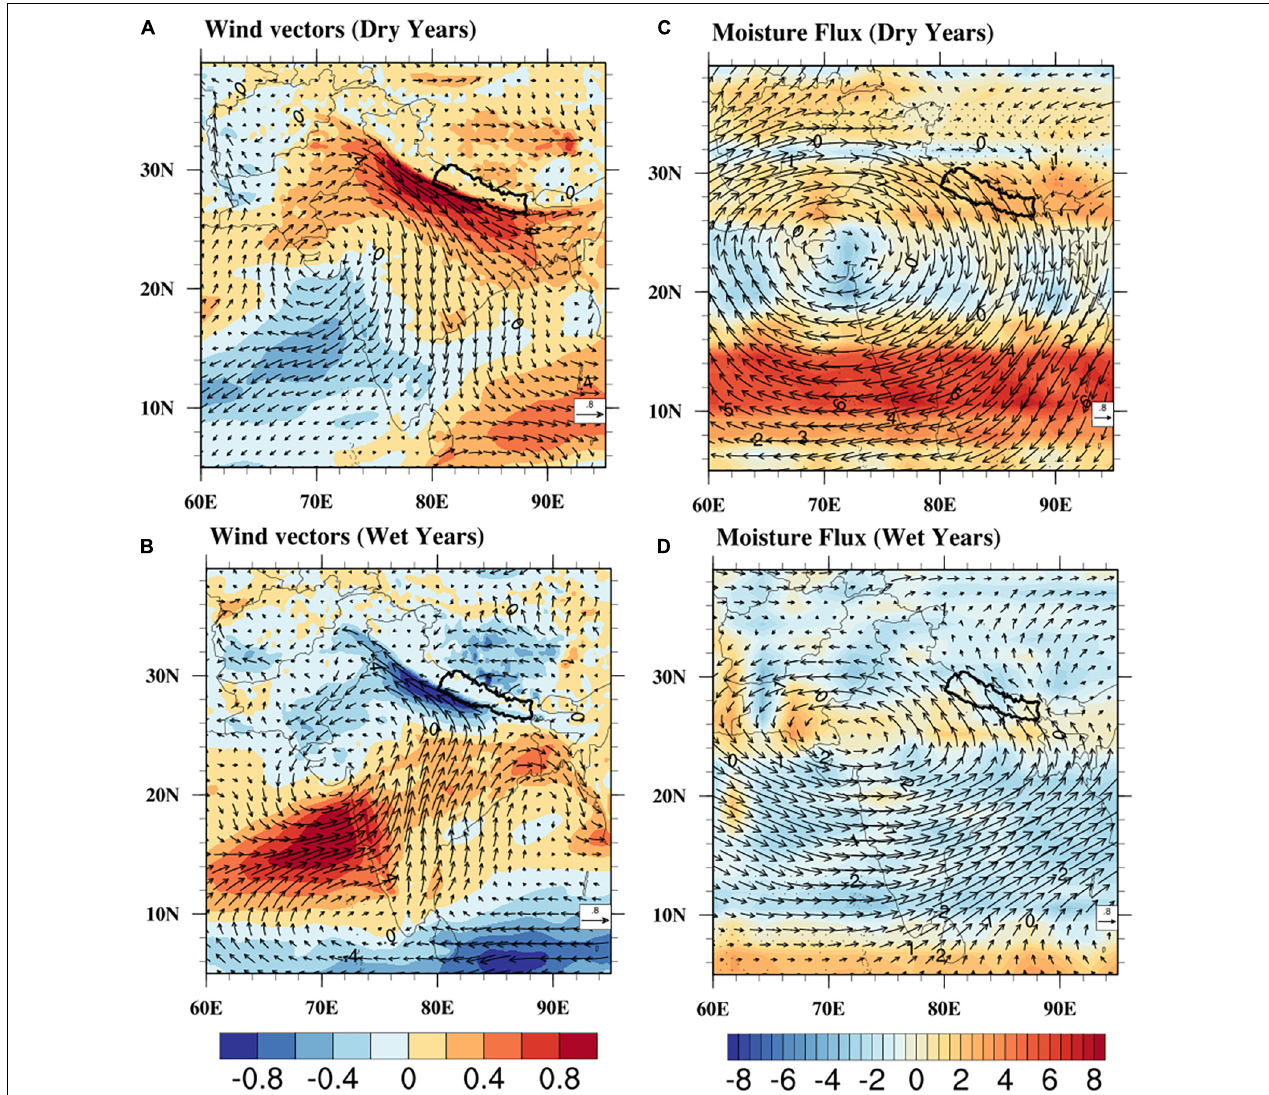
FIGURE 10 | Wind anomaly vectors (ms − 1 ) at 850 hPa (shading indicates the zonal component of wind anomalies) for (A) dry years, (B) wet years. Vertically Integrated Water Vapour Flux (10 − 5 , kg m − 2 s − 1 , the shading indicates negative anomalies convergence and positive anomalies divergence) for (C) dry years, and (D) wet years based on ERA5 reanalysis data from 1987 to 2015. The dotted points represent the significance at a 95% confidence